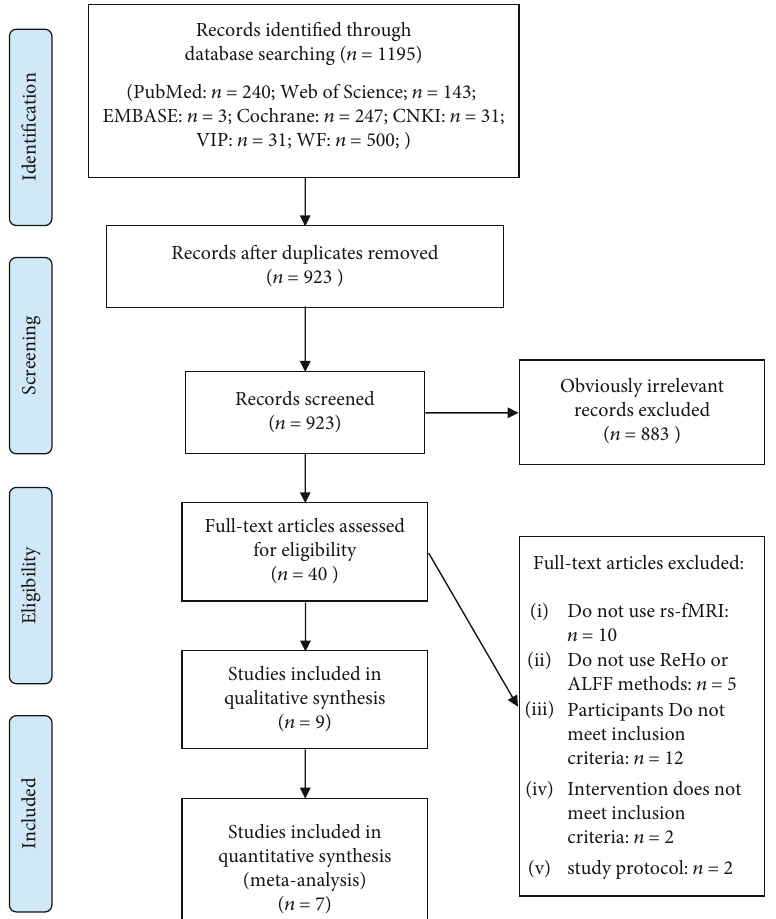
Figure 1: Flowchart for study inclusion and exclusion